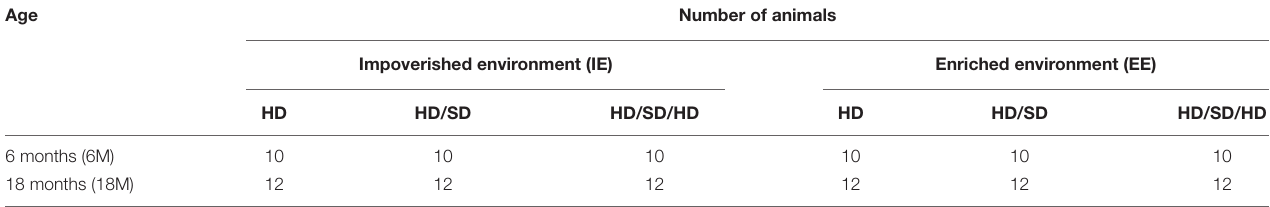
TABLE 1 | Number of animals per experimental groups. Age Number of animals Impoverished environment (IE) Enriched environment (EE)